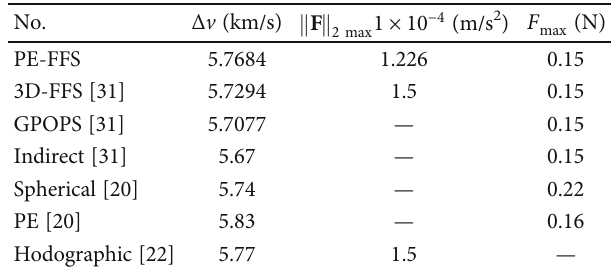
Table 3: Comparison of the Earth-Mars rendezvous trajectory results with di ff erent